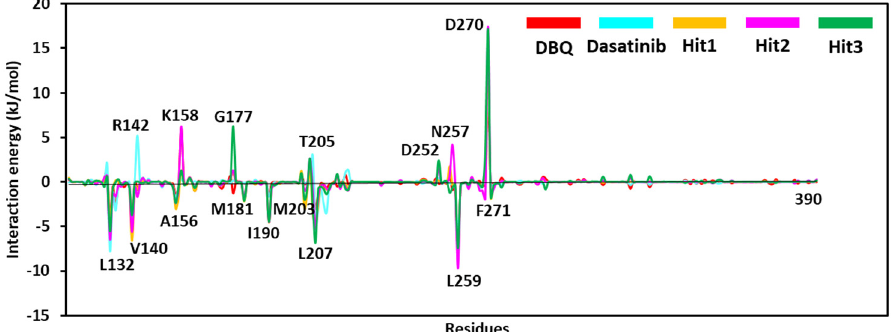
Figure 8. The energy decomposition plot of each residue in the corresponding simulated system was obtained from the MM-PBSA calculation.